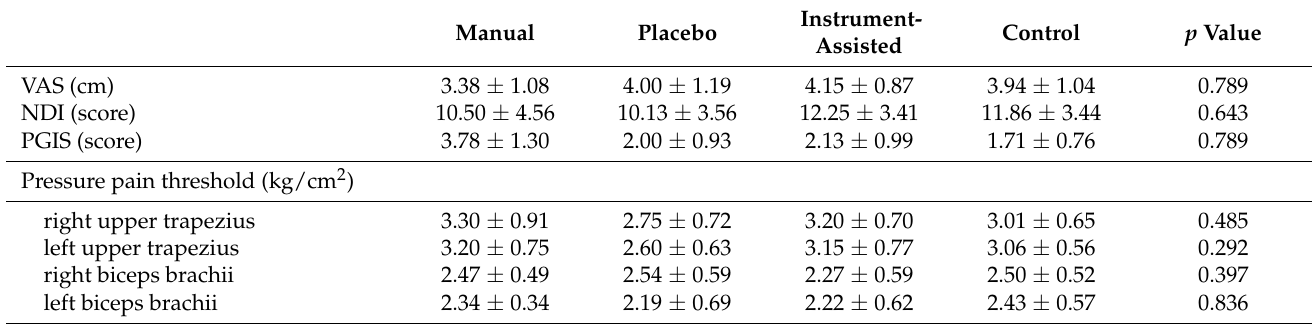
Table 1. Baseline comparison between